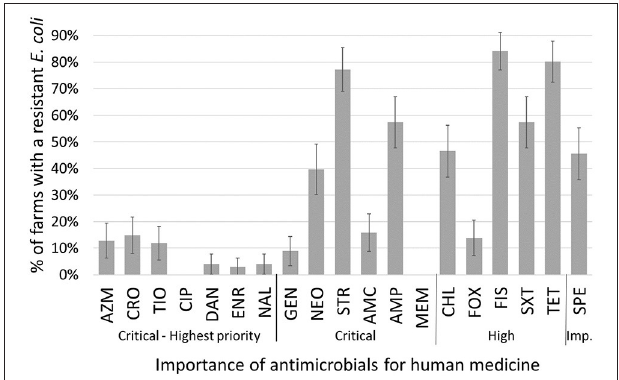
FIGURE 2 | Proportion of farms with a least one resistant (intermediate and resistant combined) Escherichia coli from any sample or any season from 101 dairy farms from Québec, Canada. On each farm, between 4 and 6 E. coli were tested for each antimicrobial. Importance of antimicrobial for human medicine according to World Health Organization ( 15). AMC amoxicillin-clavulanic acid; AMP, ampicillin; AZM, azithromycin; CHL, chloramphenicol; CIP, ciprofloxacin; CRO, ceftriaxone; DAN, danofloxacin; ENR, enrofloxacin; FIS, sulfisoxazole; FOX, cefoxitin; GEN, gentamicin; MEM, meropenem; NAL, nalidixic acid; NEO, neomycin; SPT, spectinomycin; STR, streptomycin; SXT, trimethoprim-sulfamethoxazole; TET, tetracycline; TIO, ceftiofur.